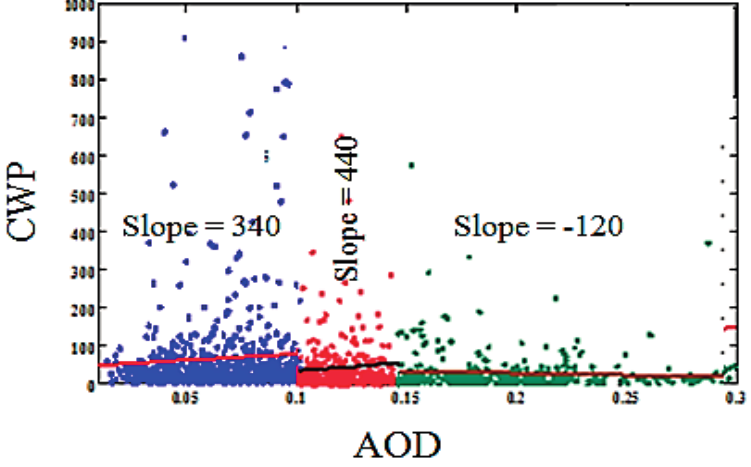
Figure 2. Correlations between aerosol optical depth (AOD) and cloud water path (CWP) in southern region of Africa for three different ranges of AOD from the same dataset. The low ranges of AOD (0; 0.1) (blue data points) and (0.1; 0.15) (red data points) show a positive correlation between AOD and CWP. The highest range of AOD (0.15; 0.3) (green data points) shows a negative correlation between AOD and CWP for (0.15; 0.3). The ranges were obtained by gradually increasing by 0.05 (arbitrary constant) AOD loading in the scatter plot CWP vs. AOD until a significant change (magnitude or sign) in the slope of the regression line